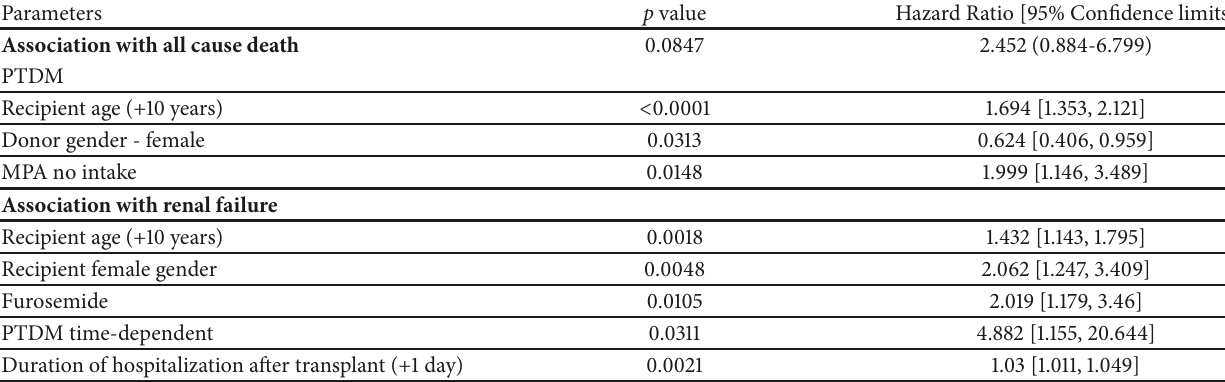
Table 3: Multivariate analyses for all cause death and renal